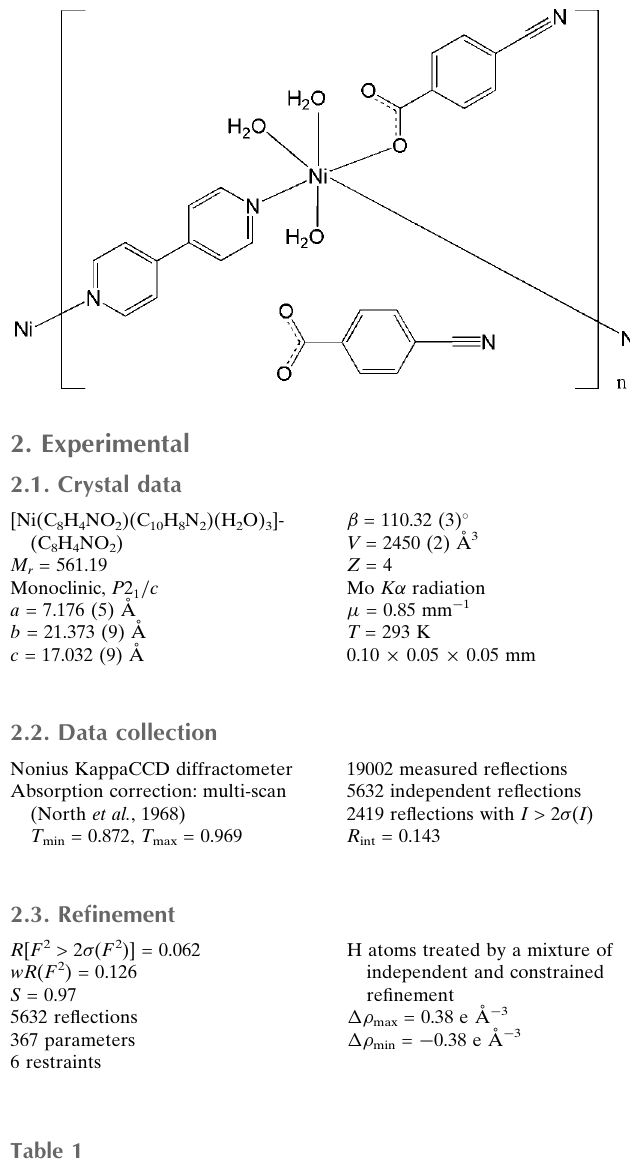
Hydrogen-bond geometry (A˚ , (cid:2)